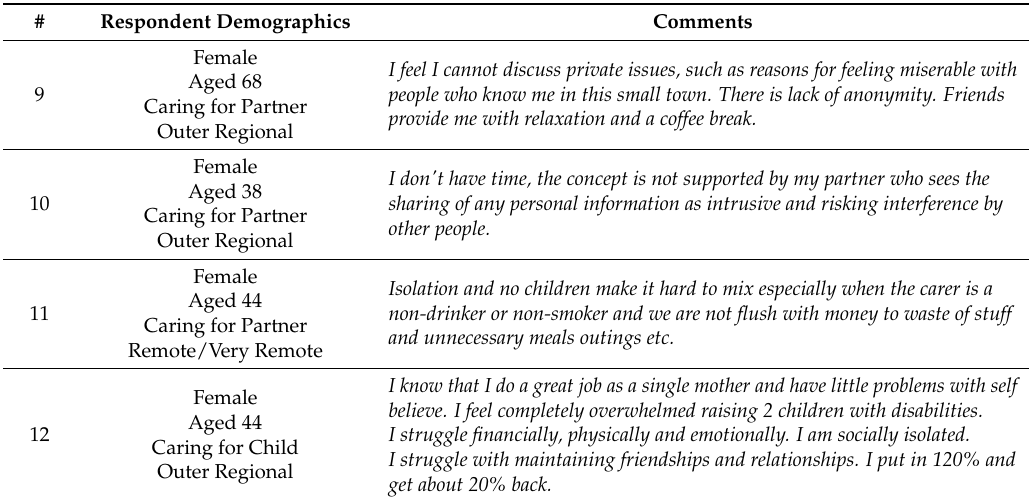
Table 5. Respondent commentary on anonymity and social isolation with respect to accessing Carer Support